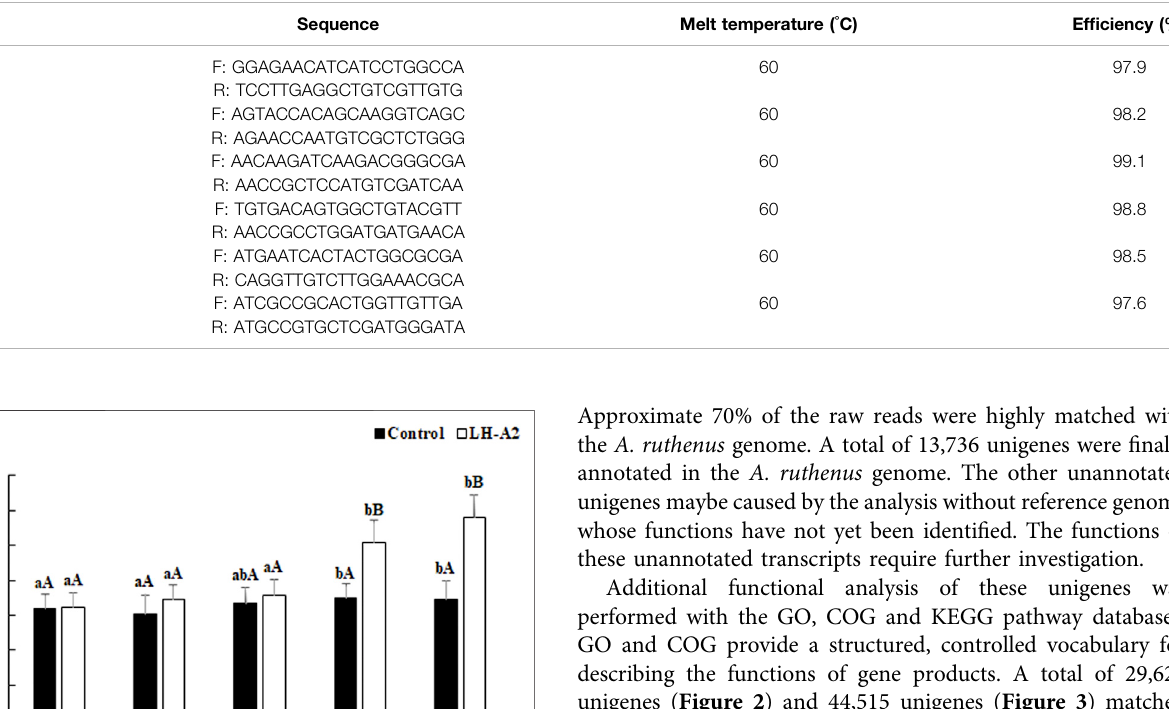
TABLE 1 | Primers used in this study.